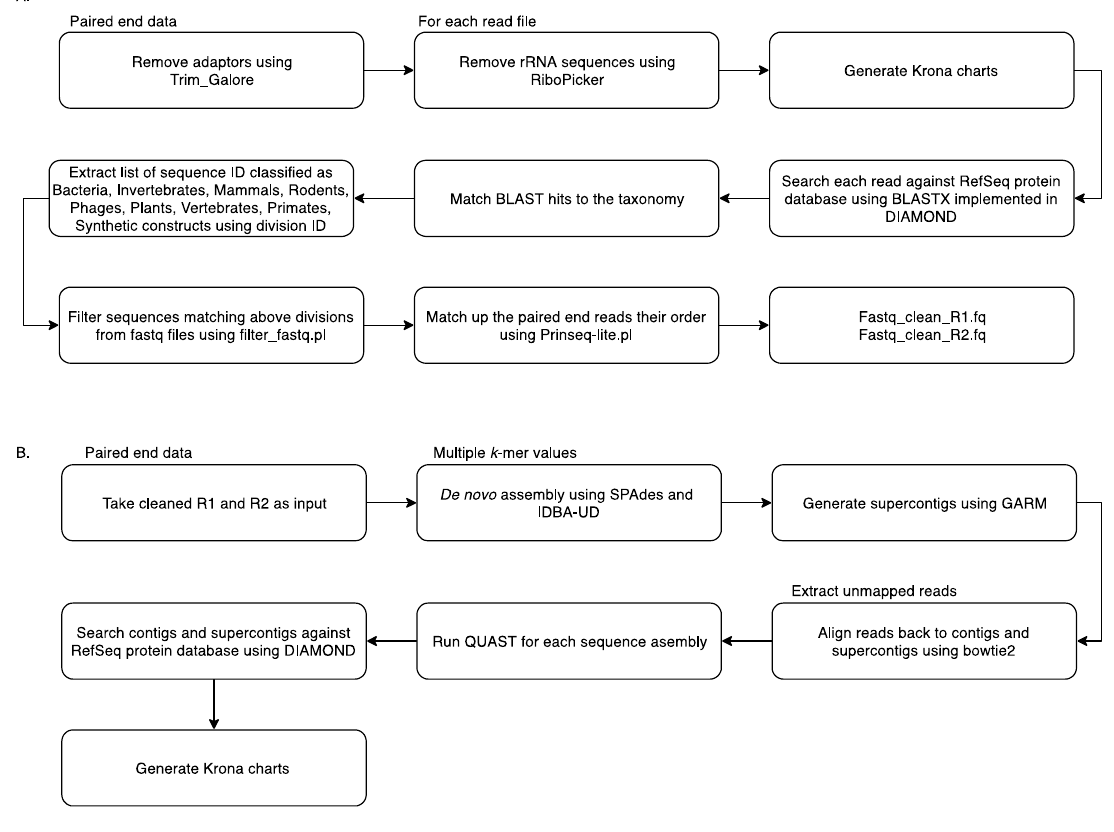
Figure 1. MetaViC workflow: ( A ) pre-processing step to remove unwanted sequences ( B ) de novo assembly and contig classification.